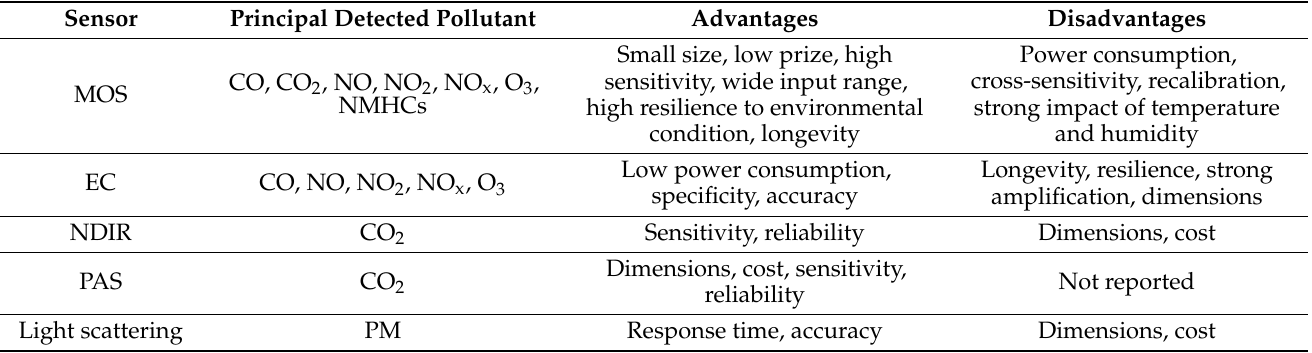
Table 2. Summary table of the major sensors’ technologies, principal detected pollutants, advantages, and